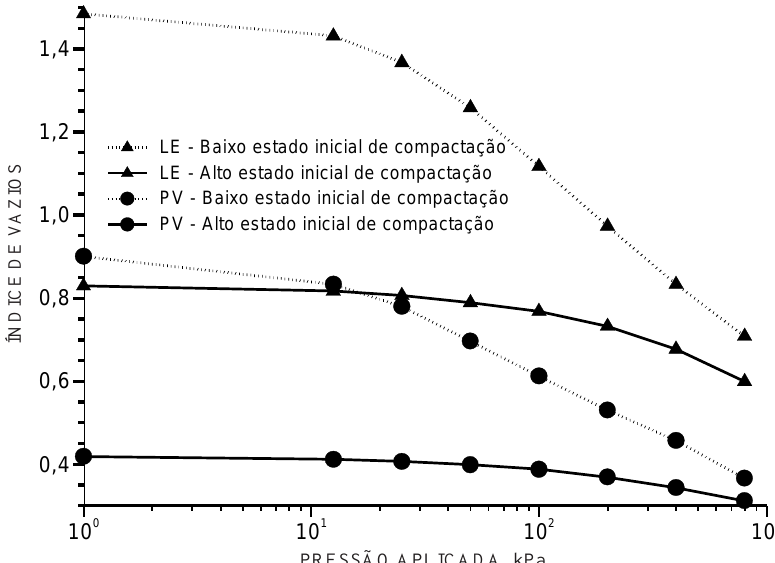
Figura 3. Curvas de compressão do Argissolo e Latossolo, considerando o estado de